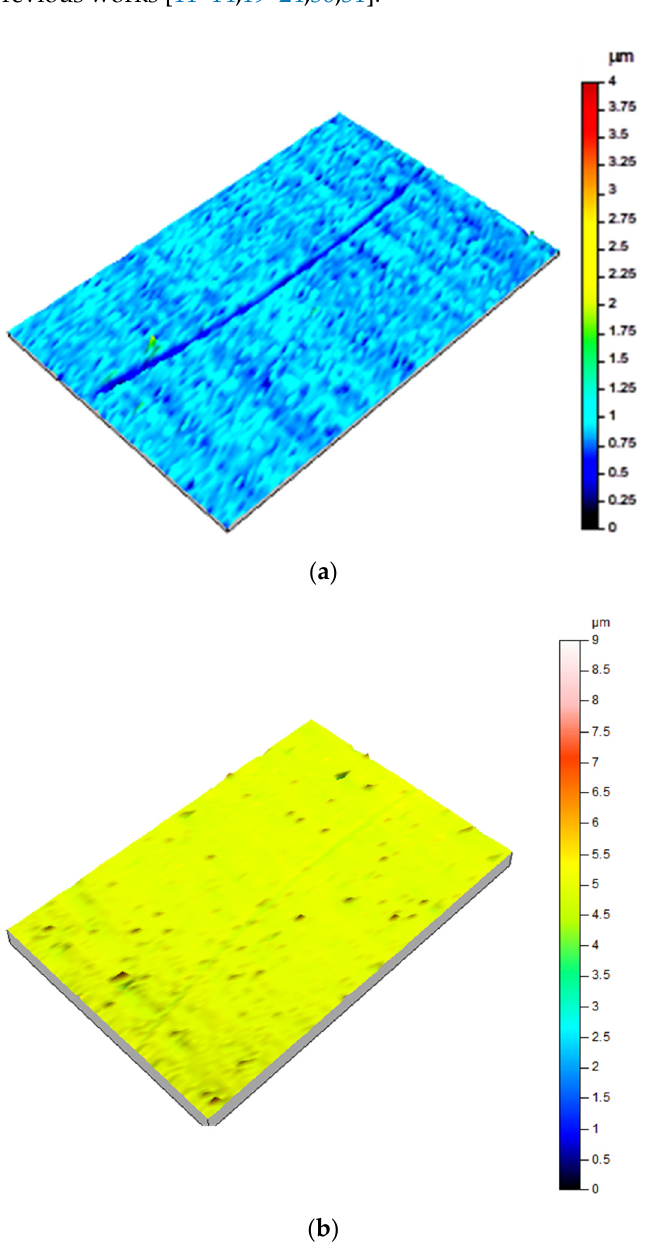
Figure 5. Surface topography profiles of AISI 316L disks after the tribological tests: ( a ) IL; ( b ) IL thin film.